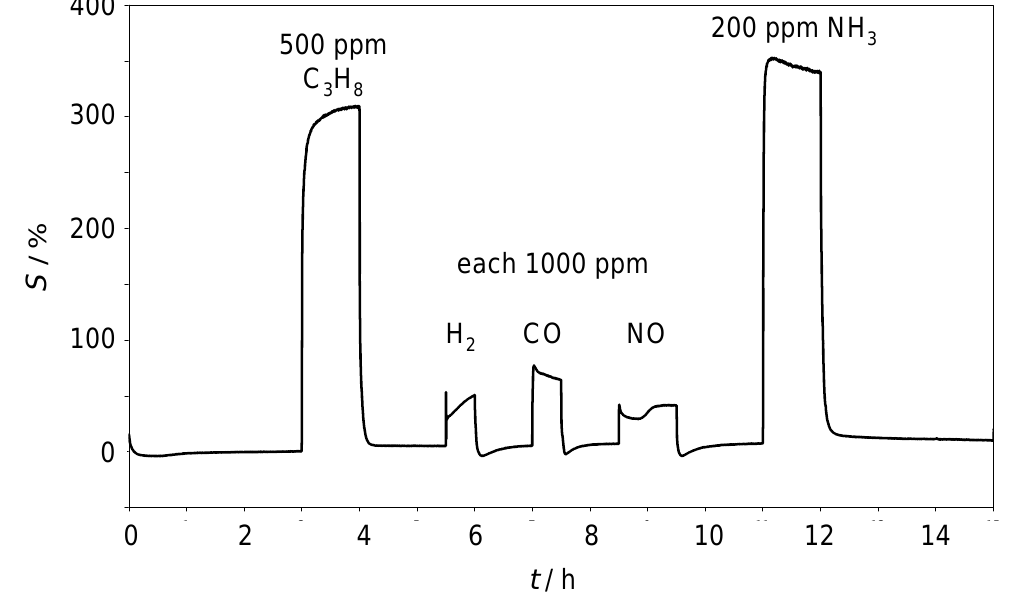
Figure 5. Sensor impedance | Z | at 3 Hz over the C Base gas 10 % O